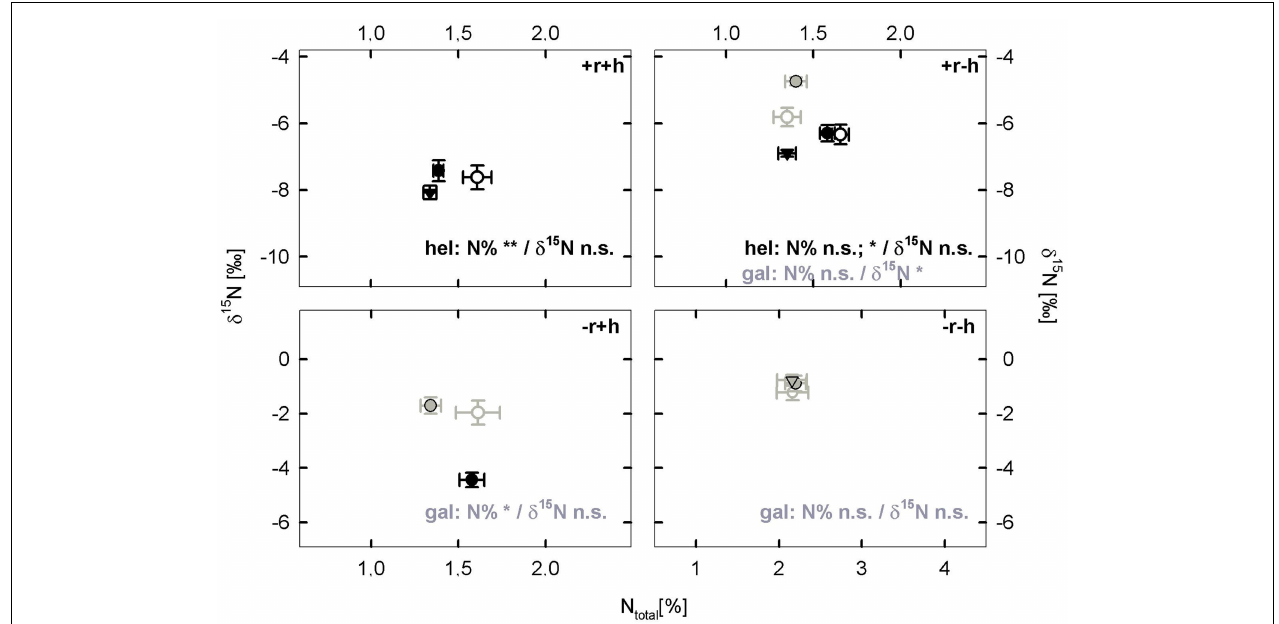
species (see Table 2 ) varied with species and treatment but in general n = 6–16 (only hel as neighbor of D. germanicum in + r − h had n = 2). Significant effects of legume neighborhood on δ 15 N and N concentration within each restoration treatment are shown as * p < 0.05, ** p < 0.01; ns, not significant, p -values from LSD-tests following ANOVA (Type I Sum of Squares). Generally, there was no legume neighbor identity effect on δ 15 N and %N, except for hel growing in + r − h , where %N was differentially affected by ID of the legume neighbor (hence two significance levels provided in